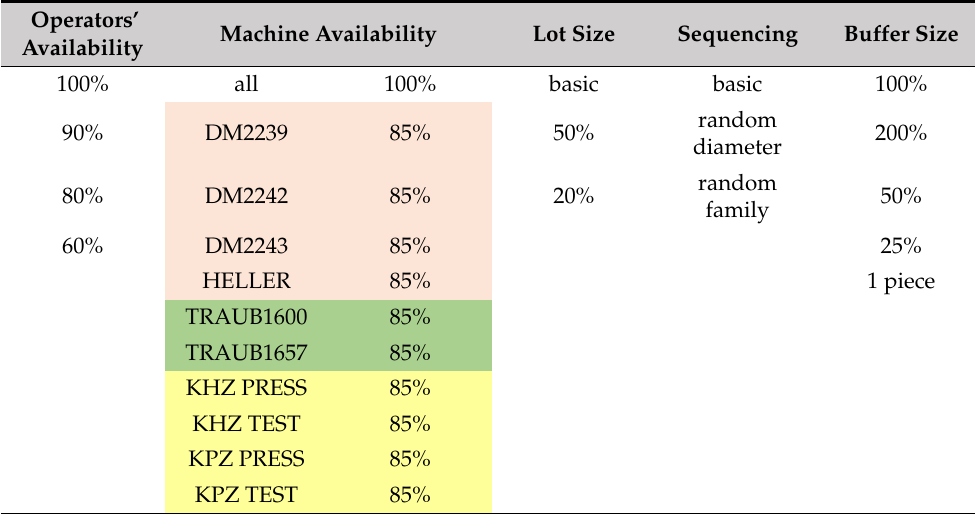
Table 1. Factors systematically changed in the rough-cut sensitivity analysis (see also Figure 4 for color coding).